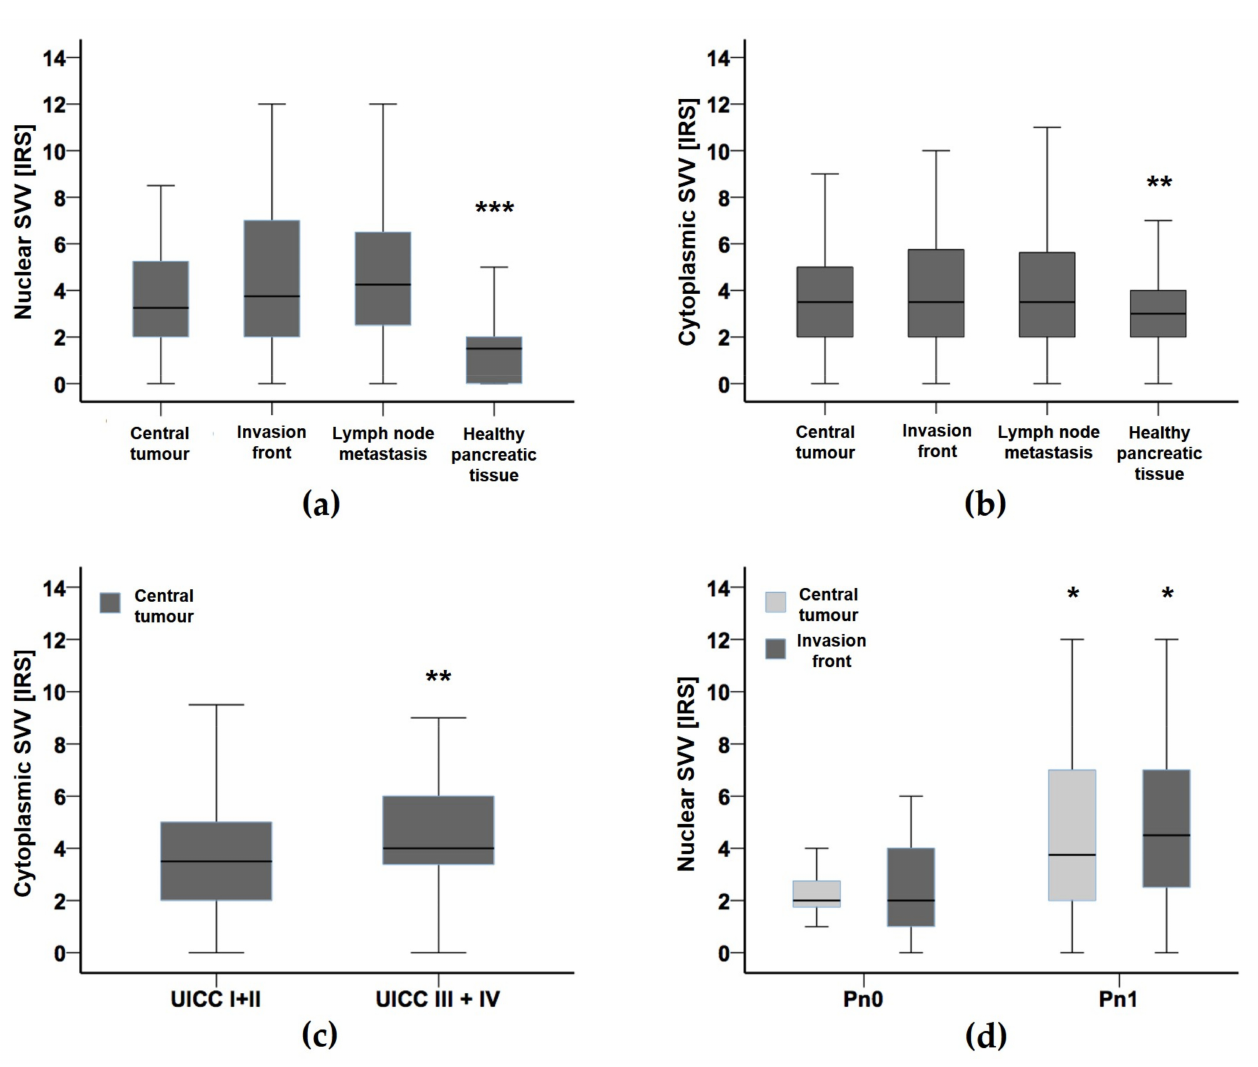
Figure 1. ( a ) Boxplot of nuclear survivin immunoreactivity expression in various tissue compartments of pancreatic ductal adenocarcinoma (PDAC): central tumour areas, tumour invasion front, lymph node metastasis, and healthy pancreatic tissue. Boxes depict the data sets comprised within the lower and upper quartiles with the median as bold cross-lines; whiskers welt data variability outside the upper and lower quartiles. *** indicates a p value ≤ 0.001 as calculated by Wilcoxon’s test. (SVV—survivin; IRS—immunoreactivity score). ( b ) Boxplot of cytoplasmic survivin expression in various tissue compartments of PDAC: central tumour areas, invasive margins, lymph node metastases, and healthy pancreatic tissue. ** indicates a p value ≤ 0.01 as calculated by Wilcoxon’s test (SVV—survivin; IRS—immunoreactivity score). ( c ) Boxplot of cytoplasmic survivin expression in central PDAC in correlation with low UICC stages I+II vs. high UICC stages III+IV. ** indicates a p value ≤ 0.01 as calculated by Mann-Whitney U test. (SVV—survivin; IRS—immunoreactivity score; UICC I+II/III+IV—grouped tumour stage classifications according to the Union Internationale Contre le Cancer (Union for International Cancer Control)). ( d ) Boxplot of nuclear survivin expression in central PDAC in correlation with perineural invasion Pn0 vs. Pn1. * indicates a p value ≤ 0.05 as calculated by Mann-Whitney U test. (SVV—survivin; IRS—immunoreactivity